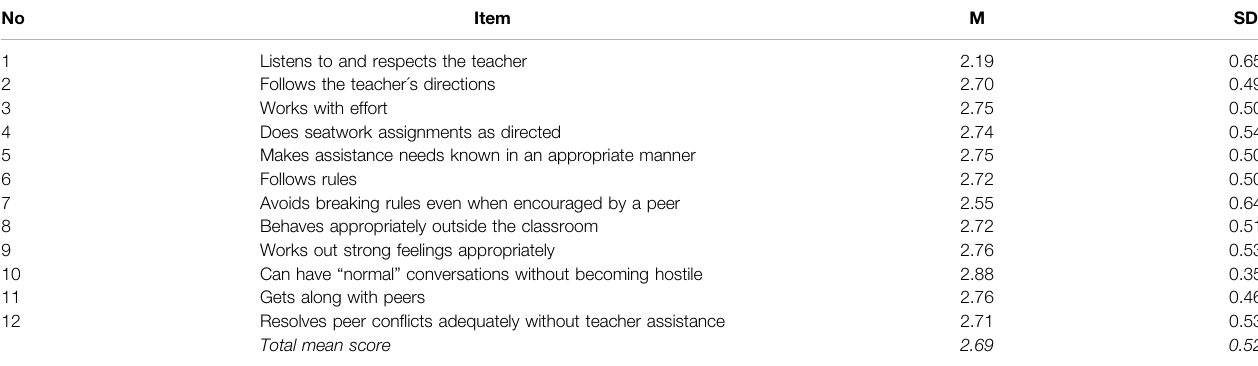
TABLE 2 | Elementary Social Behavior Assessment items, sample means, and standard deviations .